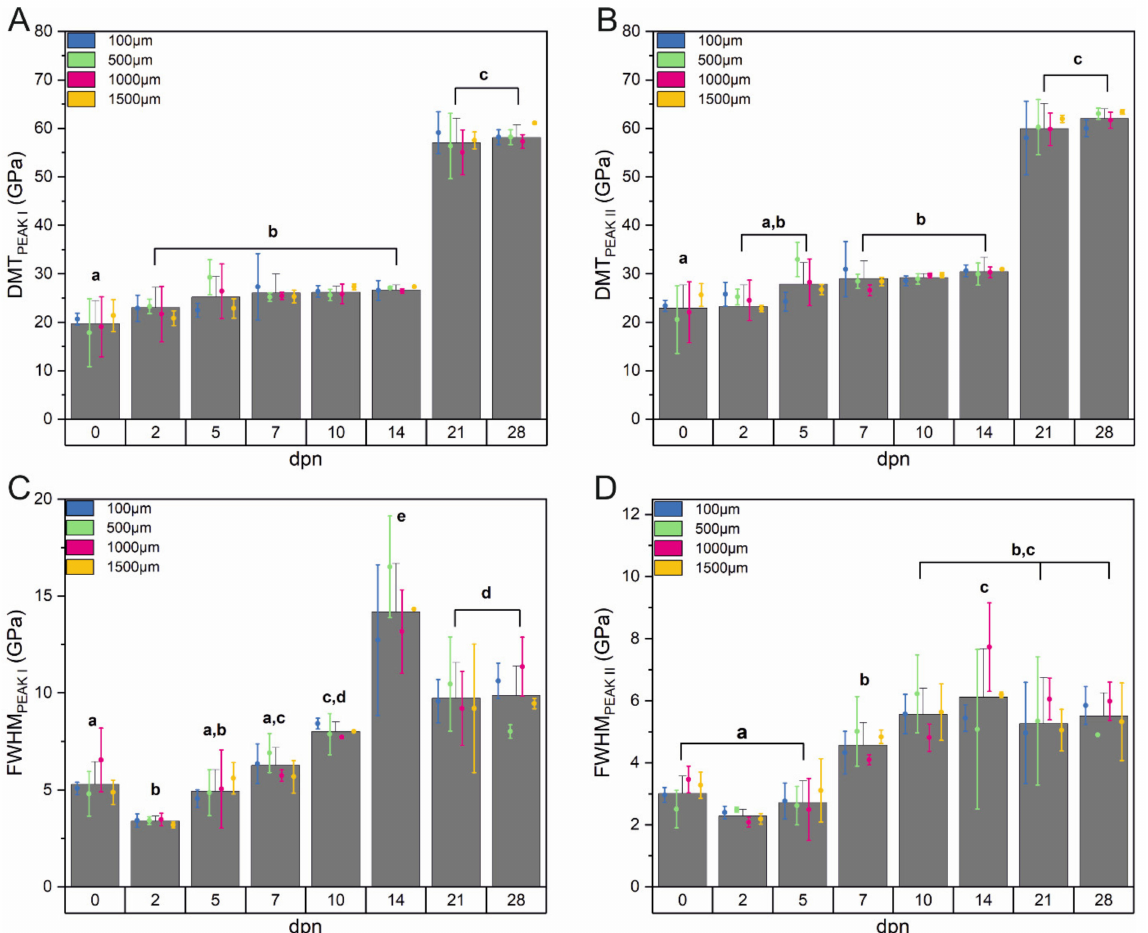
Figure 10. The average values of DMT modulus and FWHM according to the day (columns) and the distance (error bars plot) with corresponding statistics for peak I ( A , C ) and peak II ( B , D ). Data are presented as mean ± SD. Different letters indicate significant differences in groups (at p <